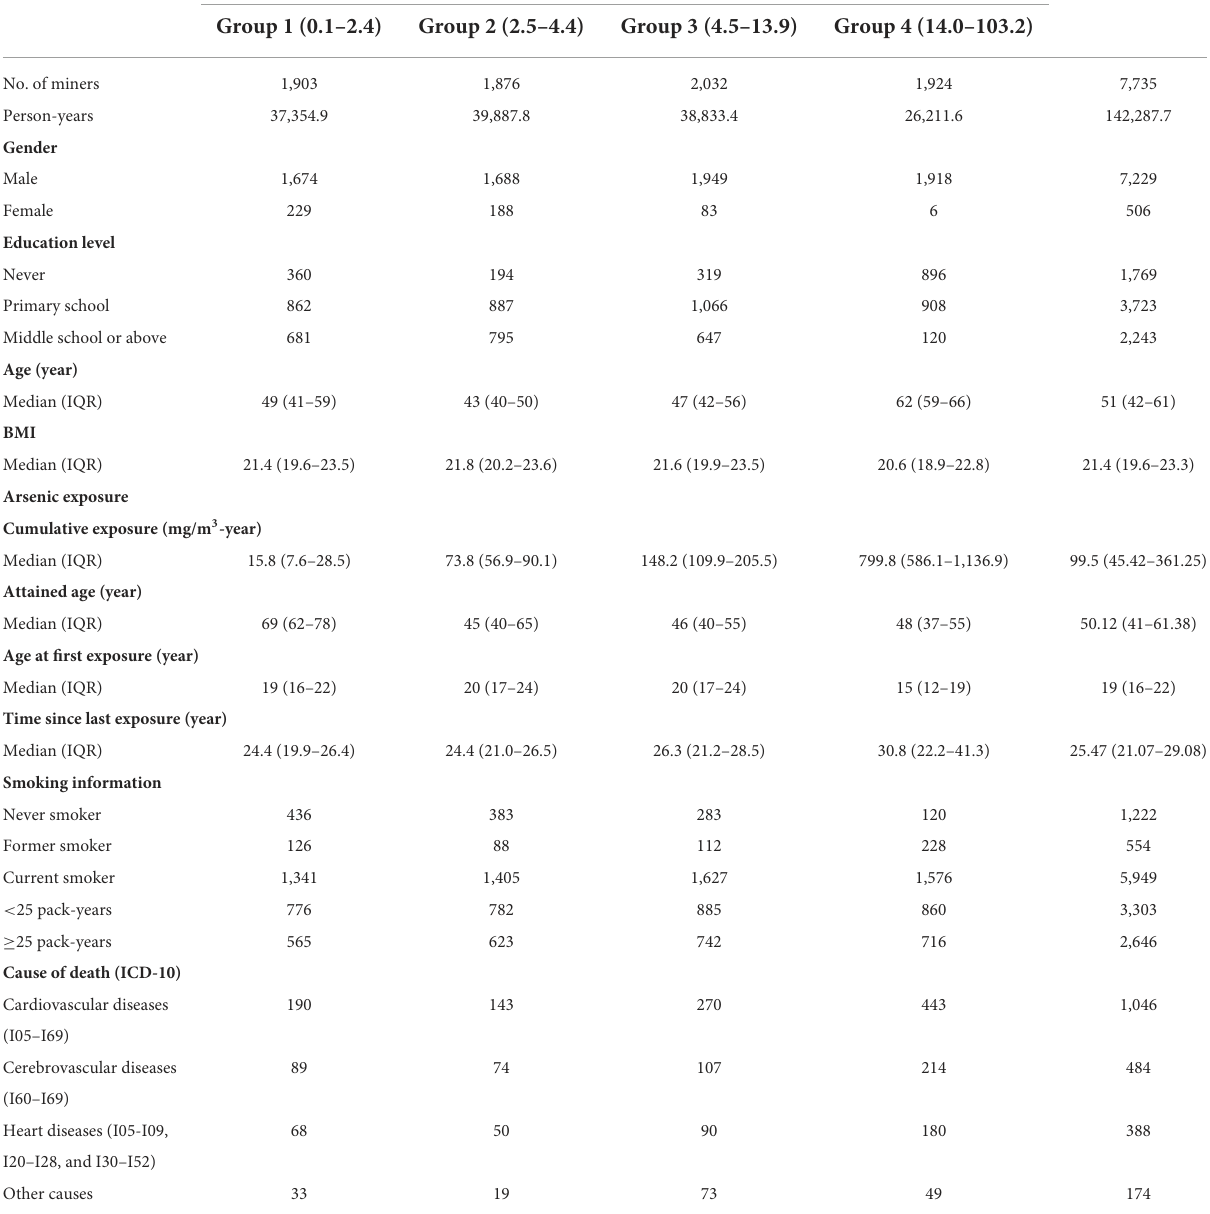
TABLE 3 Baseline characteristics and cardiovascular disease deaths among the YTC cohort